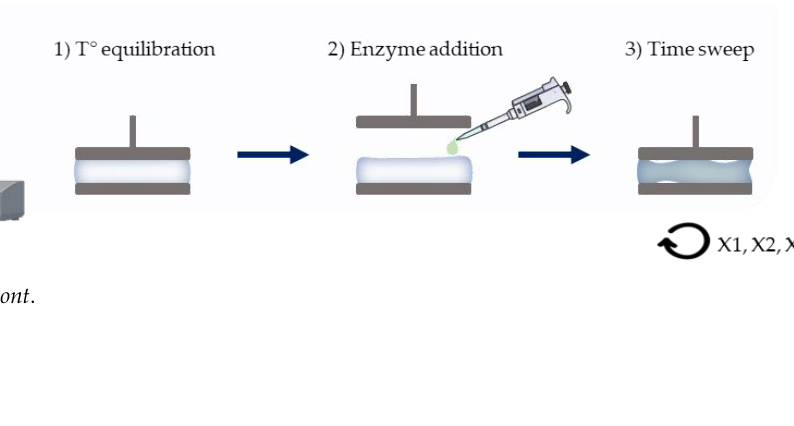
Figure 2. Evaluation of PNT4 degradation by single or multidose injections of Hylenex or Hyalase enzymes, followed by rheological time sweeps. ( A ) Schematic of the method used to degrade the PNT4 gels by single or multidose enzyme injections, ( B ) Evolution of the storage modulus of PNT4 gels over time, measured by time sweeps (37 °C, strain 0.1%, 1 Hz) after single, double, or triple injections of the Hylenex enzyme. For all conditions, the total volume of enzyme added is 90 μL, for a total enzymatic concentration of 34.6 U · mL − 1 ; blue arrows indicate enzyme addition, ( C ) First de- rivative curves of single, double, and triple dose injections, ( D ) Evolution of the storage modulus of PNT4 gels over time, measured by time sweeps (37 °C, strain 0.1%, 1 Hz) after single, double, or triple injections of the Hyalase enzyme. For all conditions, the total volume of enzyme added is 60 μL, for a total number of 277.8 U · mL − 1 ; blue arrows indicate enzyme addition, ( E ) First derivative curves of single, double, and triple dose injections; blue arrows indicate enzyme injections with the Hyalase enzyme, ( F ) Crossover time at which multidose storage moduli are lower than with a single